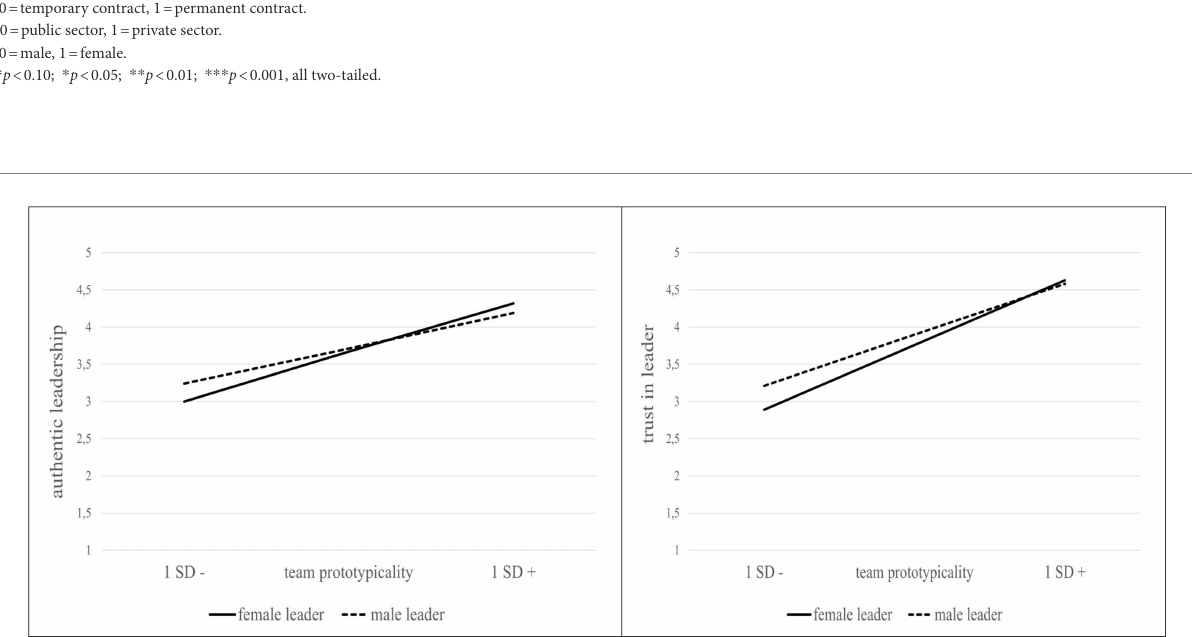
male leaders ( b = 0.73, SE = 0.06, t = 11.26, p < 0.001; see Figure 6). Thus, hypothesis 5 was